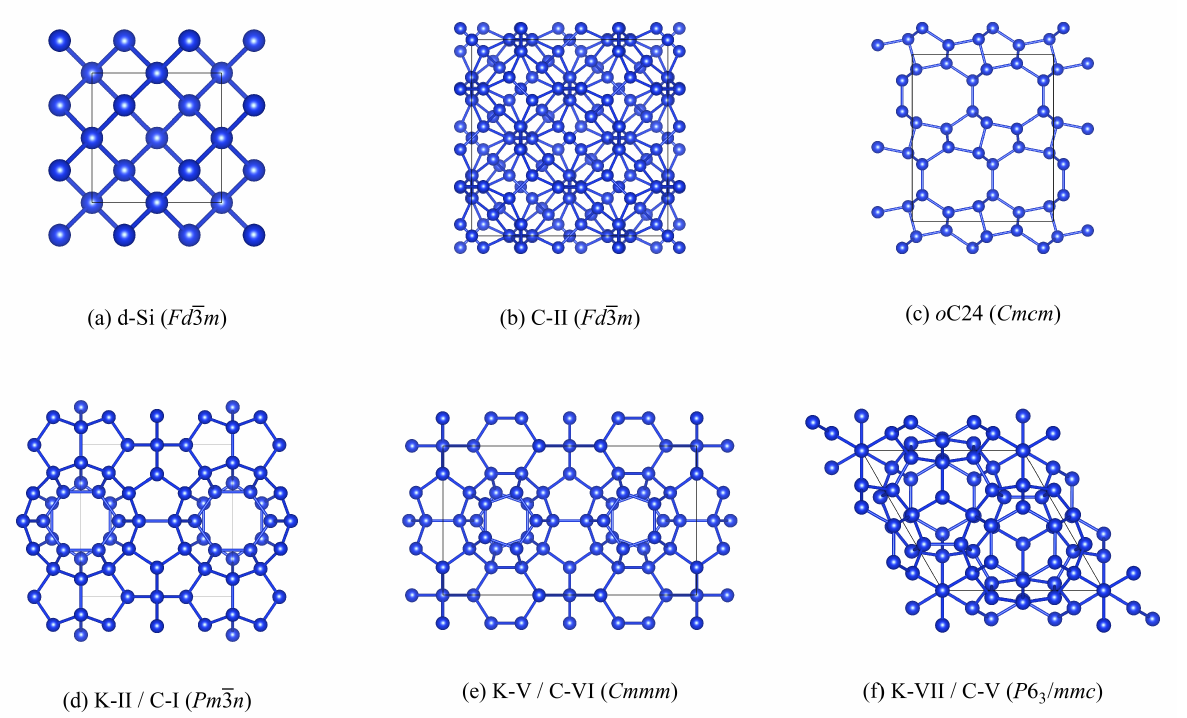
Figure 1. Images of the six structures examined in this work: ( a ) diamond Si (d-Si); ( b ) the Type-II clathrate (C-II); ( c ) the “ o C24” structure reported in Ref. [36]; ( d ) the Type-I clathrate reported as Si II in Ref. [35] (K-II/C-I); ( e ) the Si V structure reported in Ref. [35], which is similar to the Type-VI K K clathrate [34] (K-V/C-VI); and ( f ) the Type-V clathrate identified as Si VII in Ref. [34] (K-VII/C-V). K These images were prepared using the VESTA software